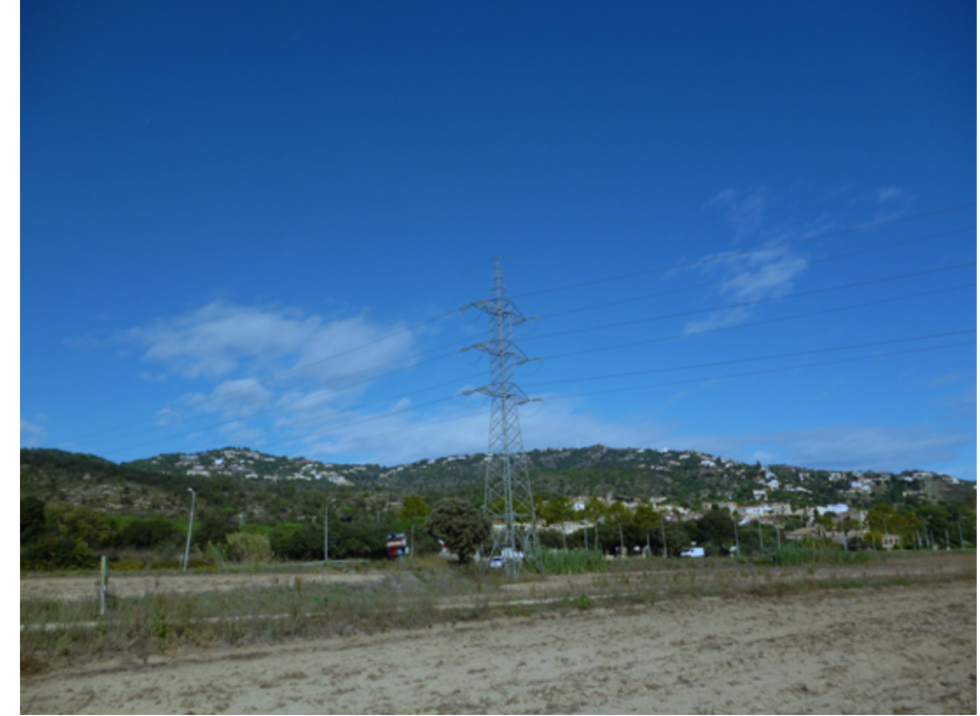
Figure 5. Pilon T-91 of the 110 kV Castell d’Aro overhead line. The photograph was taken from the observation point at 1.5 h, − 45 ◦ ,